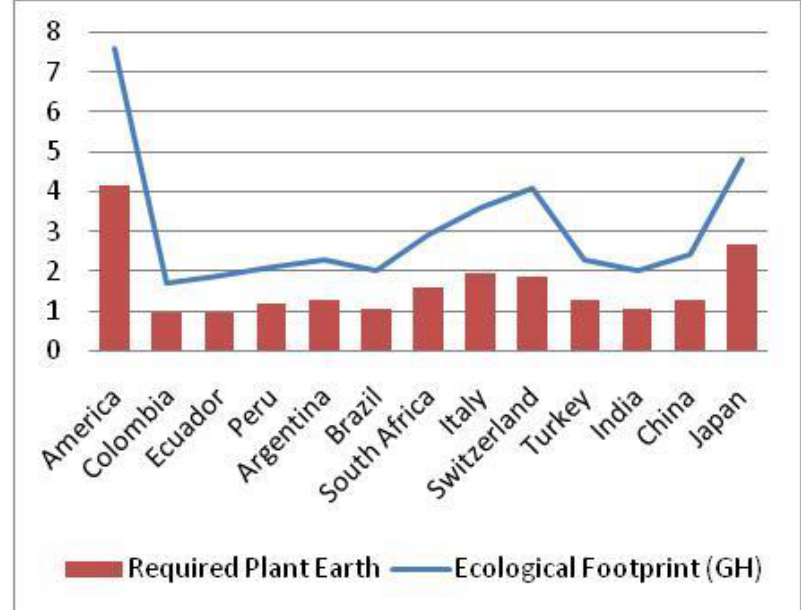
Figure 2: Ecological footprint and required plant earth in different